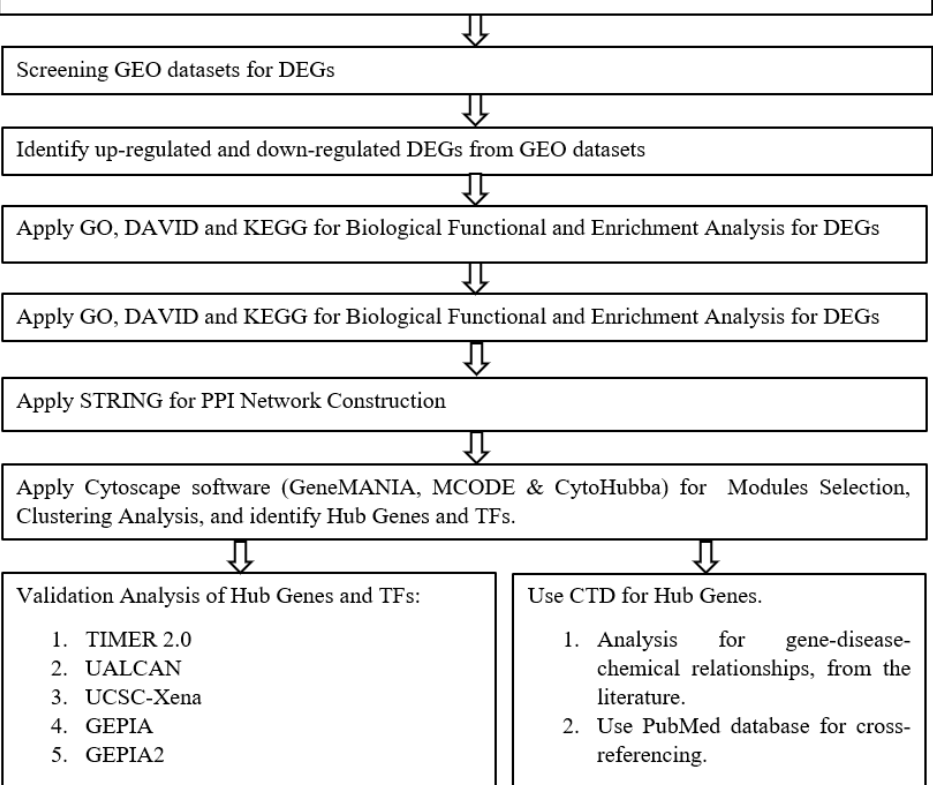
Figure 12. The flow chart depicts the steps to evaluate EDCs’ influence on the molecular prognosis and pathways of aggressive PCa by using different bioinformatic tools and datasets. and pathways of aggressive PCa by using different bioinformatic tools and